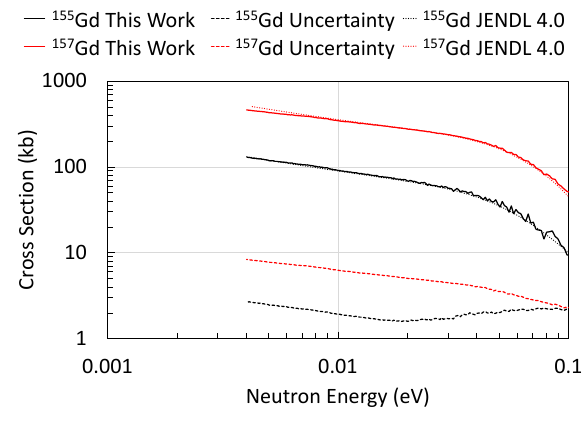
Figure 7. Derived preliminary total cross sections of 155 Gd and 157 Gd and uncertainties of the cross sections and together with values of JENDL-4.0 at 300